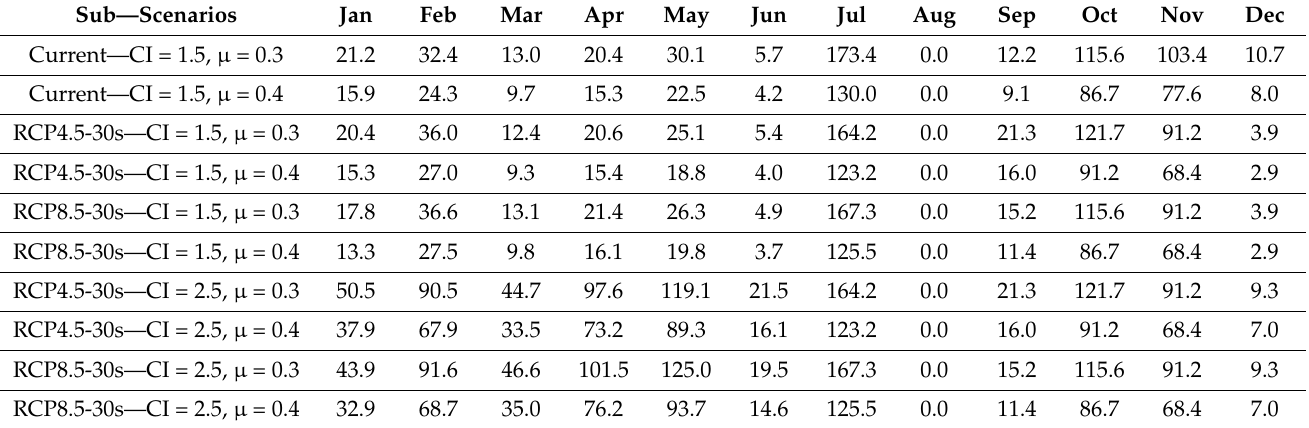
Table 6. The IWD in the Babai River Basin under different sub-scenarios (in Mm 3